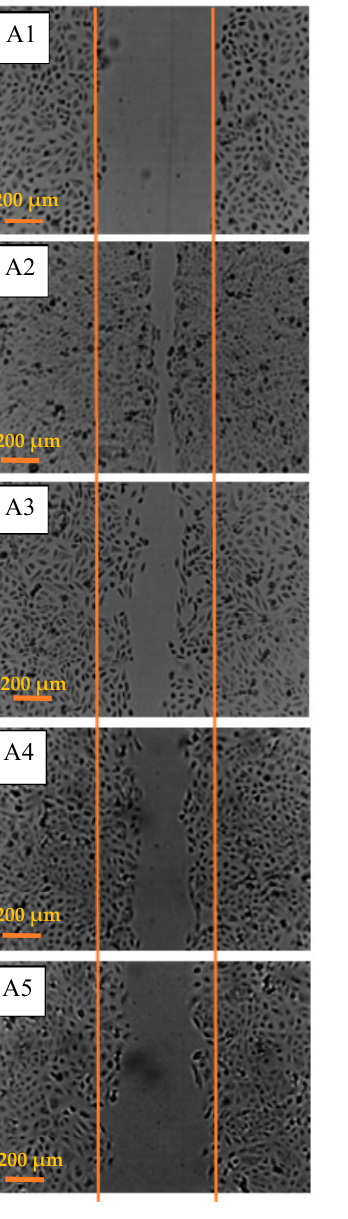
Figure 5. Effect of IR and/or AuNPs on cell motility in vitro. A ) DU145 (prostate) cancer cells; A1 ) Figure 5. E ff ect of IR and / or AuNPs on cell motility in vitro. ( A ) DU145 (prostate) cancer cells; untreated controls at 0 h, A2 ) untreated control at 24 h, A3 ) cells exposed to 5 Gy X-rays after 24 h, ( A1 ) untreated controls at 0 h, ( A2 ) untreated control at 24 h, ( A3 ) cells exposed to 5 Gy X-rays after A4 ) cells treated with 1 mM AuNPs at 24 h and, A5 ) cells treated with IR and AuNPs at 24 h and, B ) 24 h, ( A4 ) cells treated with 1 mM AuNPs at 24 h and, ( A5 ) cells treated with IR and AuNPs at 24 h and, lung (A549) cancer cells; B1 ) untreated controls at 0 h, B2 ) untreated control at 24 h, B3 ) cells exposed ( B ) lung (A549) cancer cells; ( B1 ) untreated controls at 0 h, ( B2 ) untreated control at 24 h, ( B3 ) cells to 5 Gy X-rays after 24 h, B4 ) cells treated with 1 mM AuNPs at 24 h and, B5 ) cells treated with IR and exposed to 5 Gy X-rays after 24 h, ( B4 ) cells treated with 1 mM AuNPs at 24 h and, ( B5 ) cells treated AuNPs at 24 h. with IR and AuNPs at 24